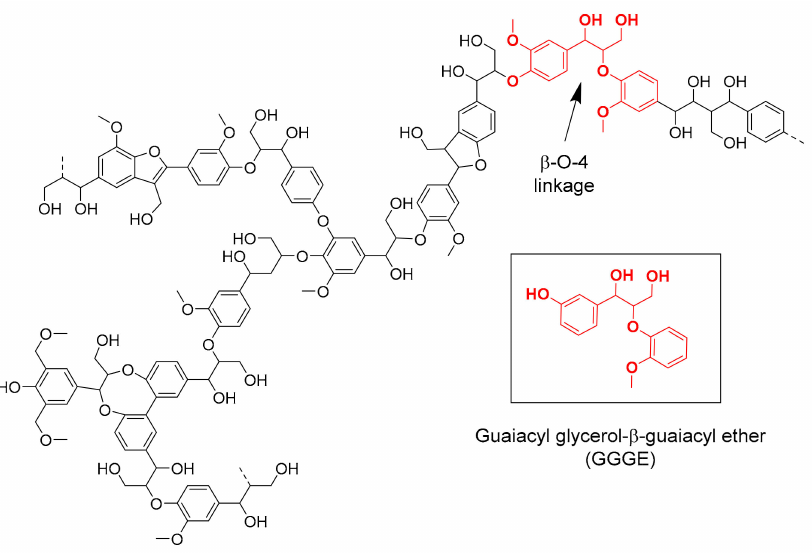
Figure 1. Schematic representation of typical lignin fragments and the corresponding β -O-4 lignin model compound guaiacyl glycerol- β -guaiacyl ether